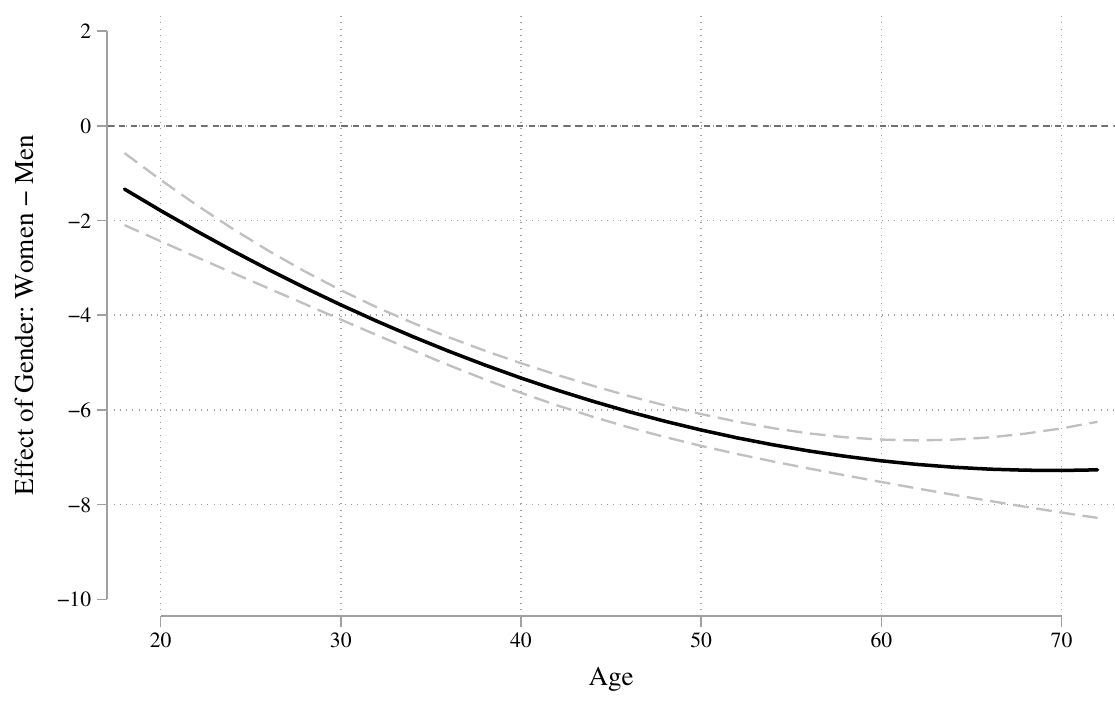
Figure 2: Average marginal effect of gender (woman = 1) across the range of age on predicted